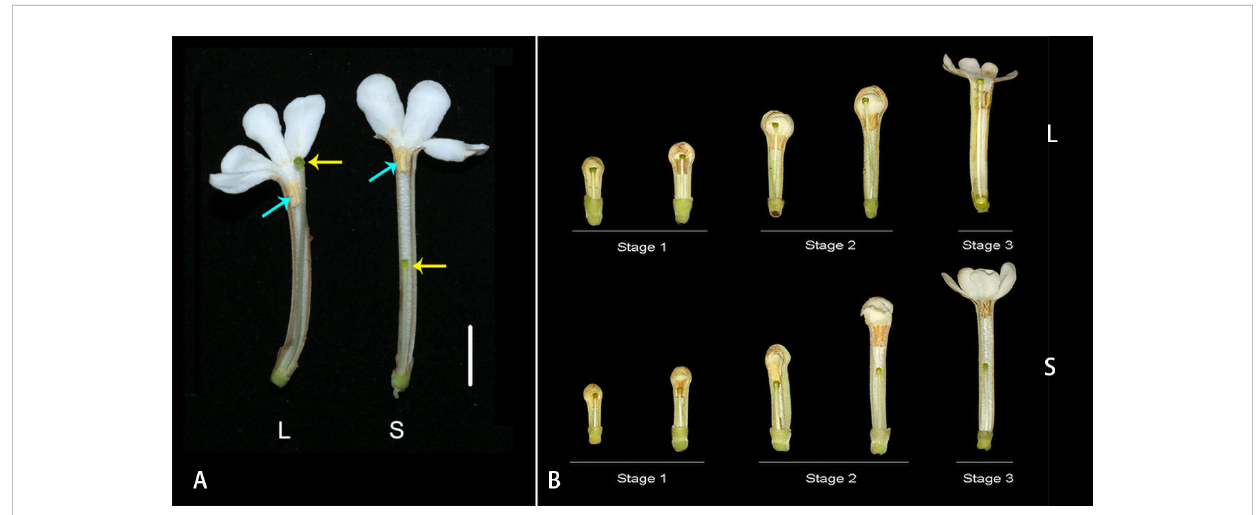
FIGURE 1 (A) Longitudinal dissection of Guettarda speciosa fl owers, showing the positions of anther and stigma in L-morph (left) and S-morph (right). Yellow arrows indicate the position of stigmas, while blue arrows indicate the position of anthers. Bar = 10 mm. (B) The development process of L- and S- morph fl owers, showing the three stages for RNA-seq material